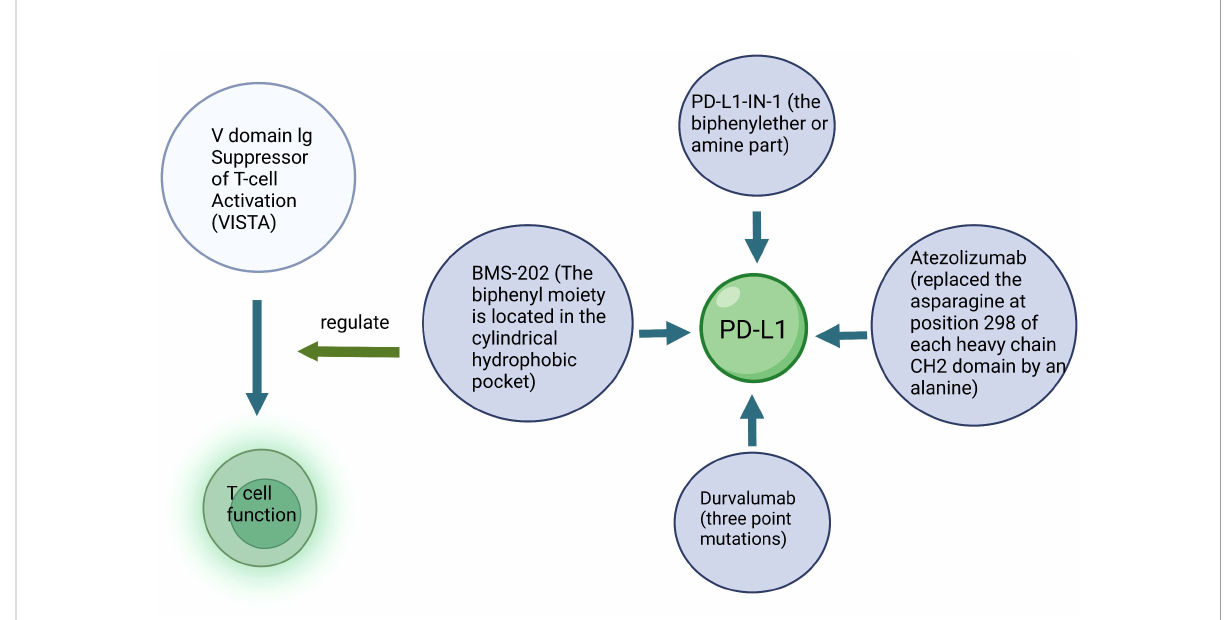
FIGURE 5 Schematic diagram of immunotherapy. Key structure of a speci fi c drug and the target cells are